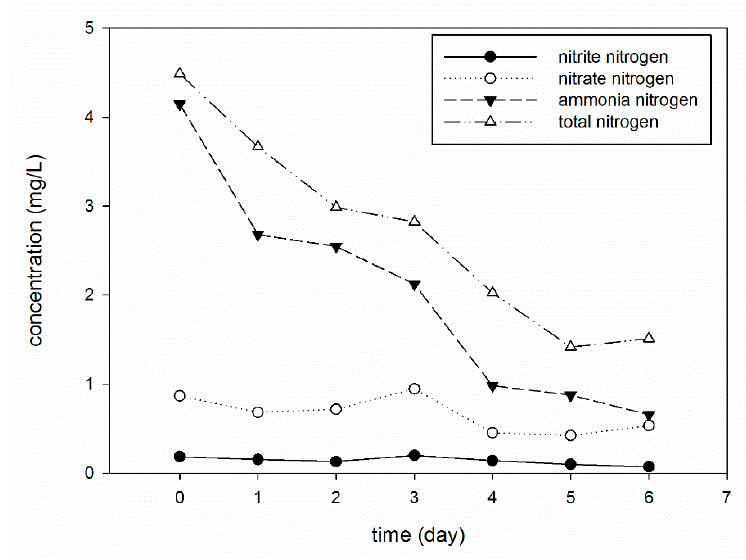
Figure 6. Removal of nitrogen.